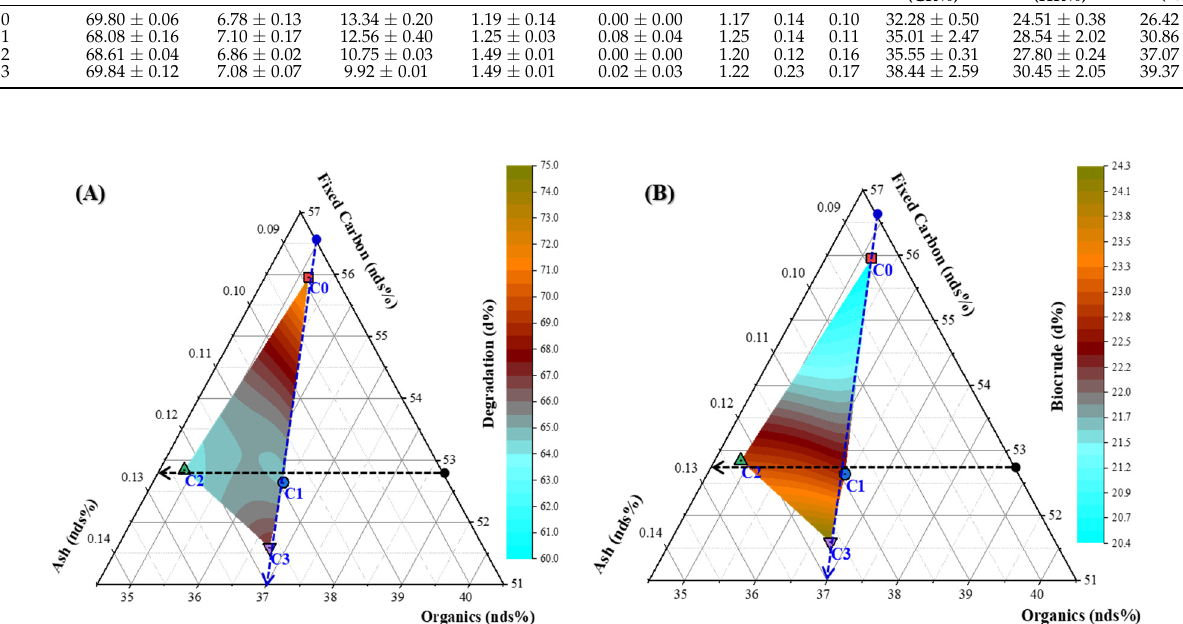
Figure 6. Effect of the compositional characteristics of NDS on hydrothermal degradation ( A ) and oil formation ( B ). From Figure 6B, as one moves almost in a straight line from C0 to C3, the (cid:1875) (cid:3003)(cid:3016) in-